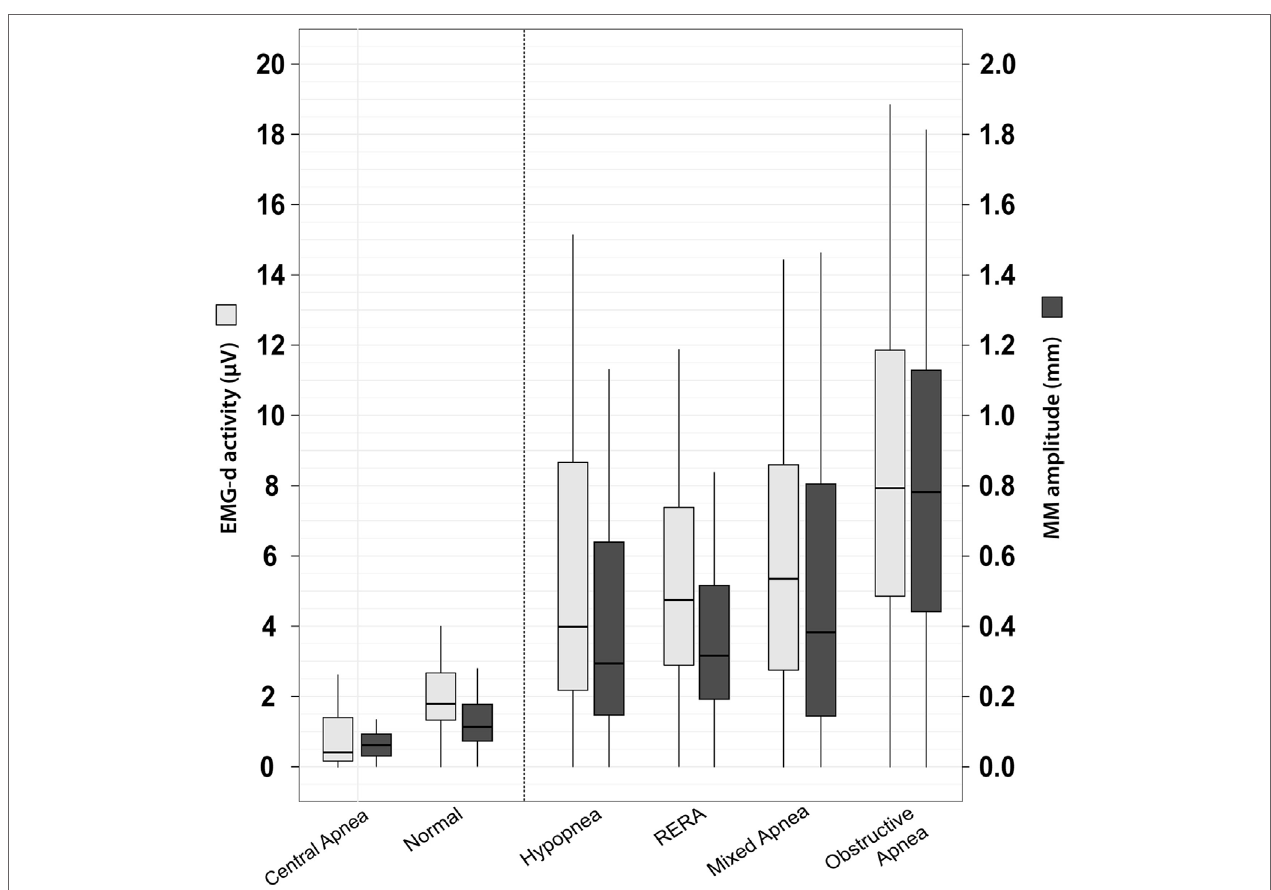
FigUre 4 | Diaphragm EMG ( EMG-d) activity and mandibular movements (MM) amplitudes among normal sleep and sleep breathing disorders. Tukey boxplots represent the median, interquartile ranges, minimum, and maximum values of EMG-d activity (gray) and MM amplitude (black) during normal and five types of sleep disordered breathing. Events ranking was based on median values of MM and EMG-d amplitudes. Numerical values of these medians are presented in e-Table S2 in Supplementary Material (Online Supplement). The pairwise quantile comparison using Harrell–Davis method indicates significant differences in median, lower, and upper quartiles of both MM and EMG-d amplitudes across the six